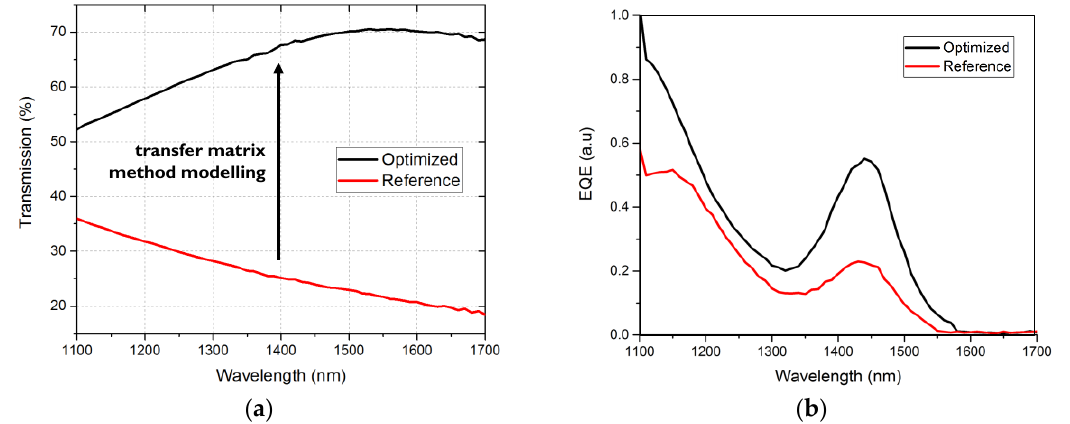
Figure 11. Top illuminated photodetector stack optimized for NIR transparency: Improvement of the top contact transparency ( a ); and experimental EQE verification ( b ).